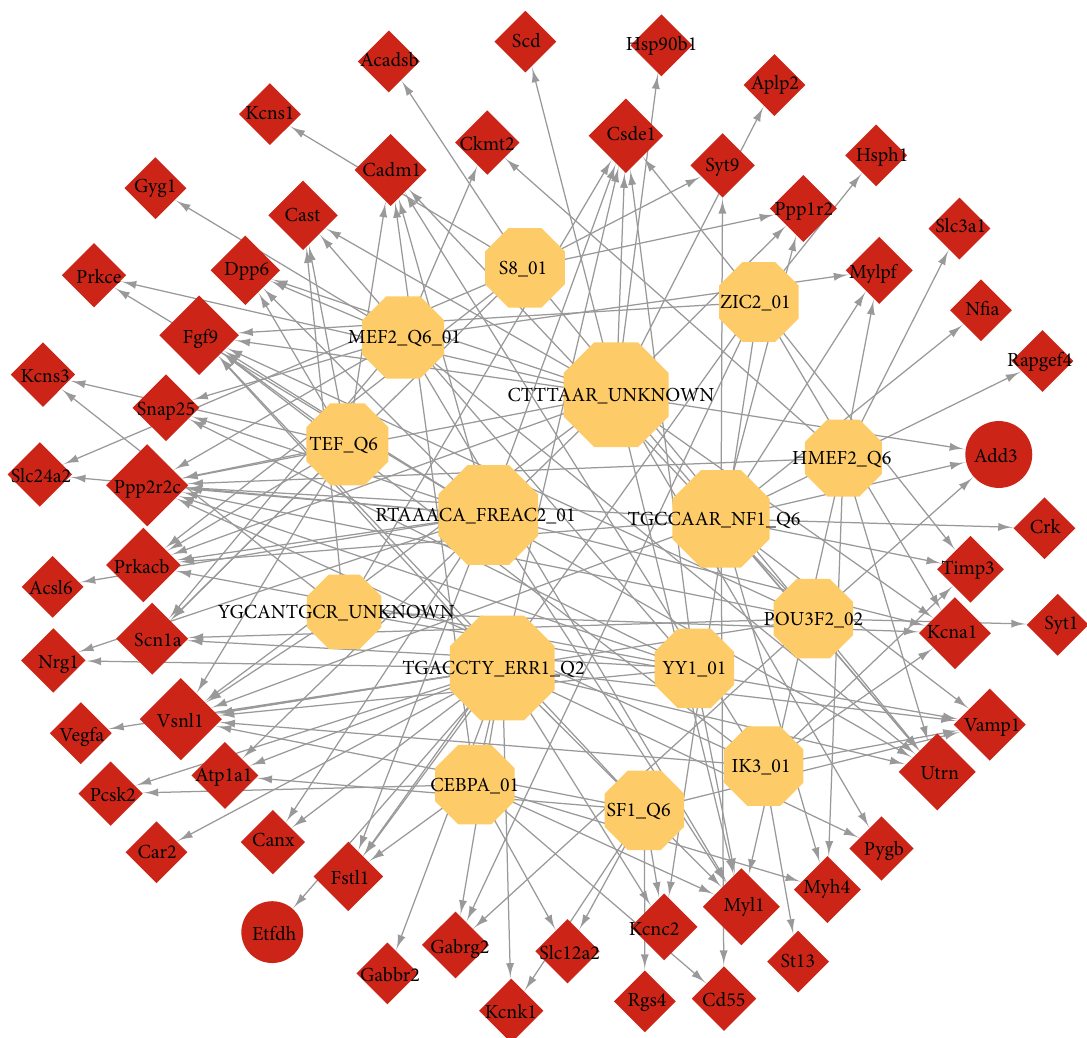
Figure 4: The transcription factor- (TF-) gene regulatory network. Red nodes indicate the cluster 1 genes, and yellow octagon nodes indicate predicted TFs. Rhomboid nodes represent downregulated genes and circular nodes represent upregulated genes. Arrow lines indicate TF- target